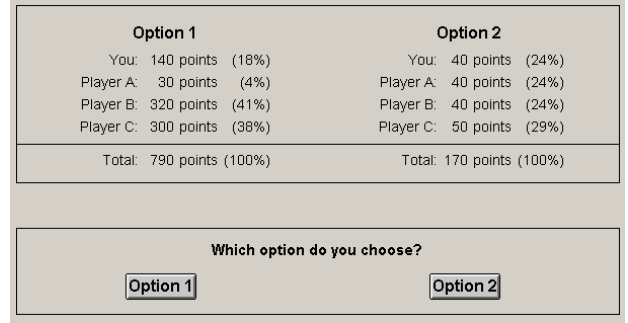
Figure 1. Example Dictator Game.